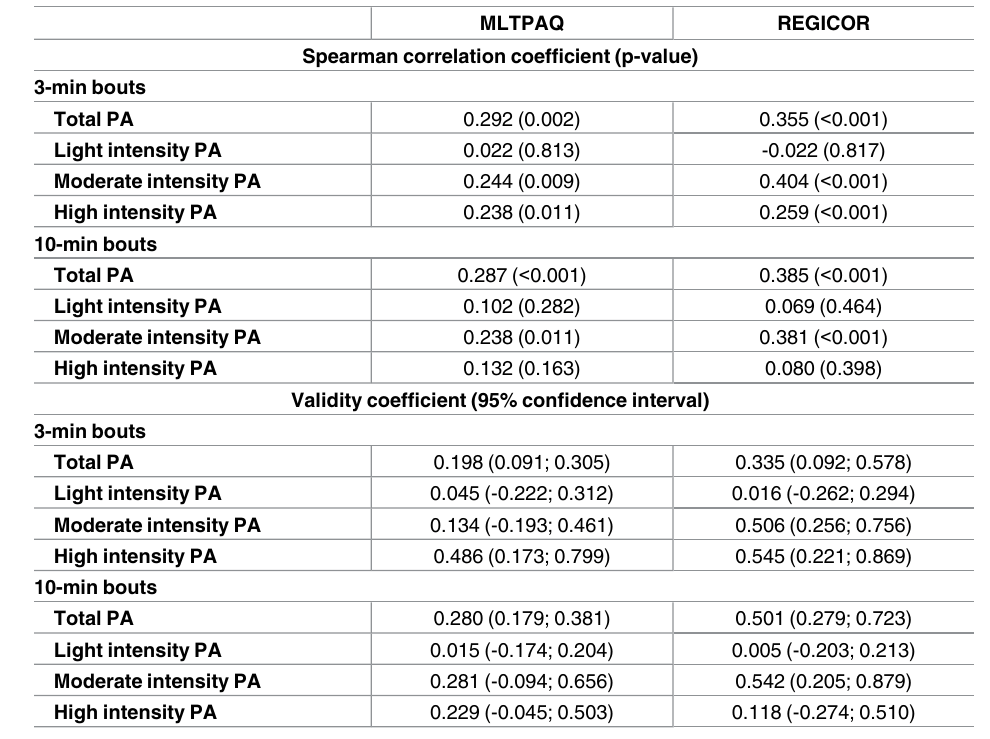
Table 5. Spearman correlation and validity coefficients between energy expenditure in physical activ- ity estimatedwith the questionnaires and accelerometer